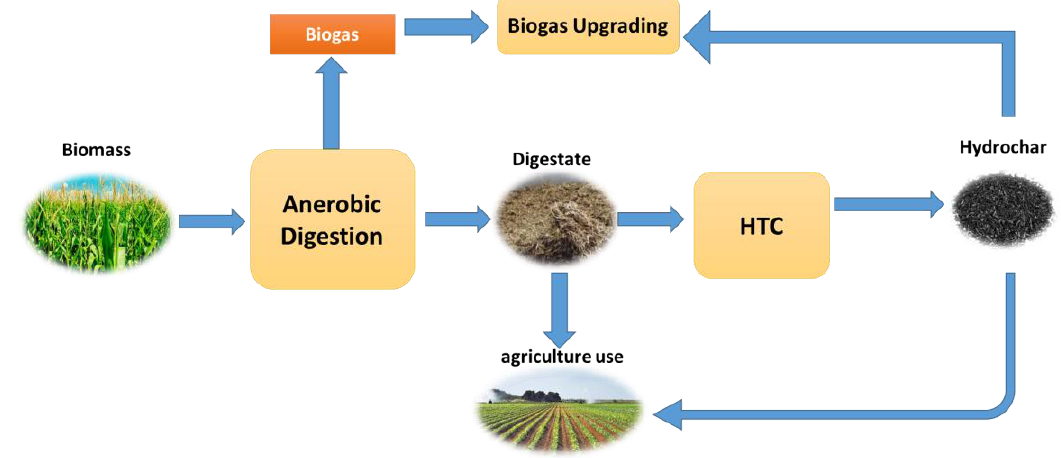
Figure 5. Coupling pathway for HTC of digestate